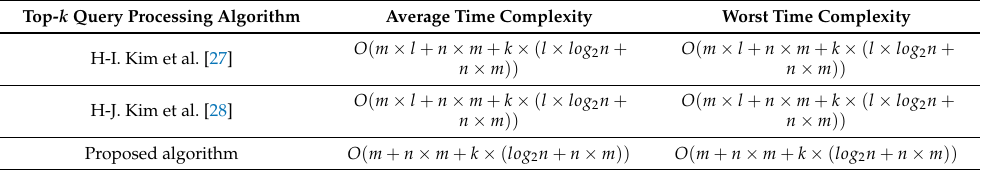
Table 6. Time complexity for proposed algorithm and existing algorithm. Top- k Query Processing Algorithm Average Time Complexity Worst Time Complexity